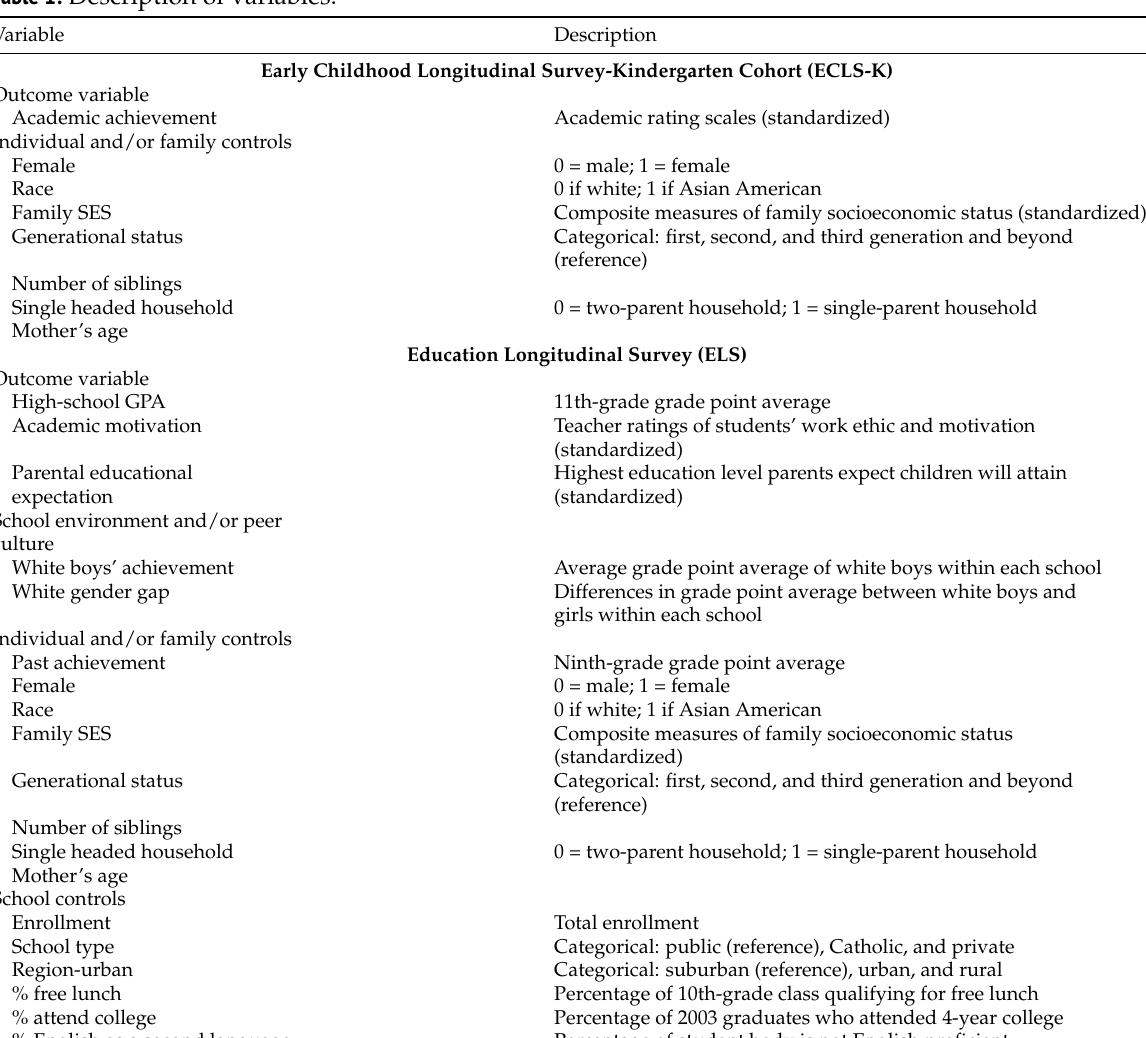
Table 1: Description of